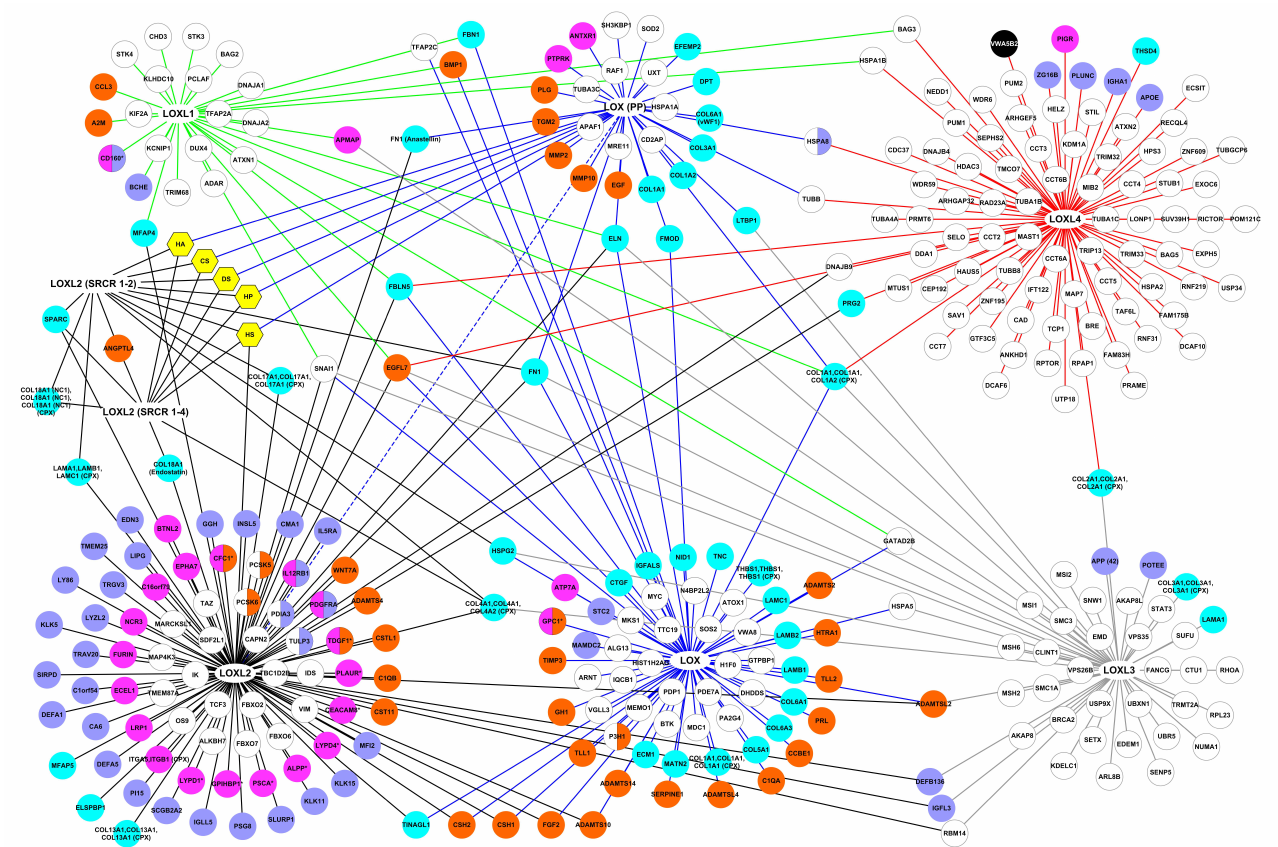
Figure 2. Interactome of the LOX family including the location of their protein binding partners. Proteins represented by nodes were color-coded according to their cellular location(s) determined by the Gene Ontology term “Cellular Component” (Supplementary Table S3): cyan: core-matrisome proteins, orange: matrisome-associated proteins, purple: extracellular pro- teins not included in the matrisome, white: intracellular proteins, pink: membrane proteins (* glycosyl-phosphatidylinositol- anchored proteins) and black: undetermined location. Yellow hexagons: glycosaminoglycans. Interactions, represented by edges, were color-coded according to the LOX family member they were connected to (blue edges: LOX interactions, green edges: LOXL1 interactions, black edges: LOXL2 interactions, grey edges: LOXL3 interactions, red edges: LOXL4 interactions, dotted blue edges: interactions between two members of the LOX family). The domains containing the binding sites are indicated when known (LOX (PP): lysyl oxidase propeptide, SRCR: Scavenger Receptor